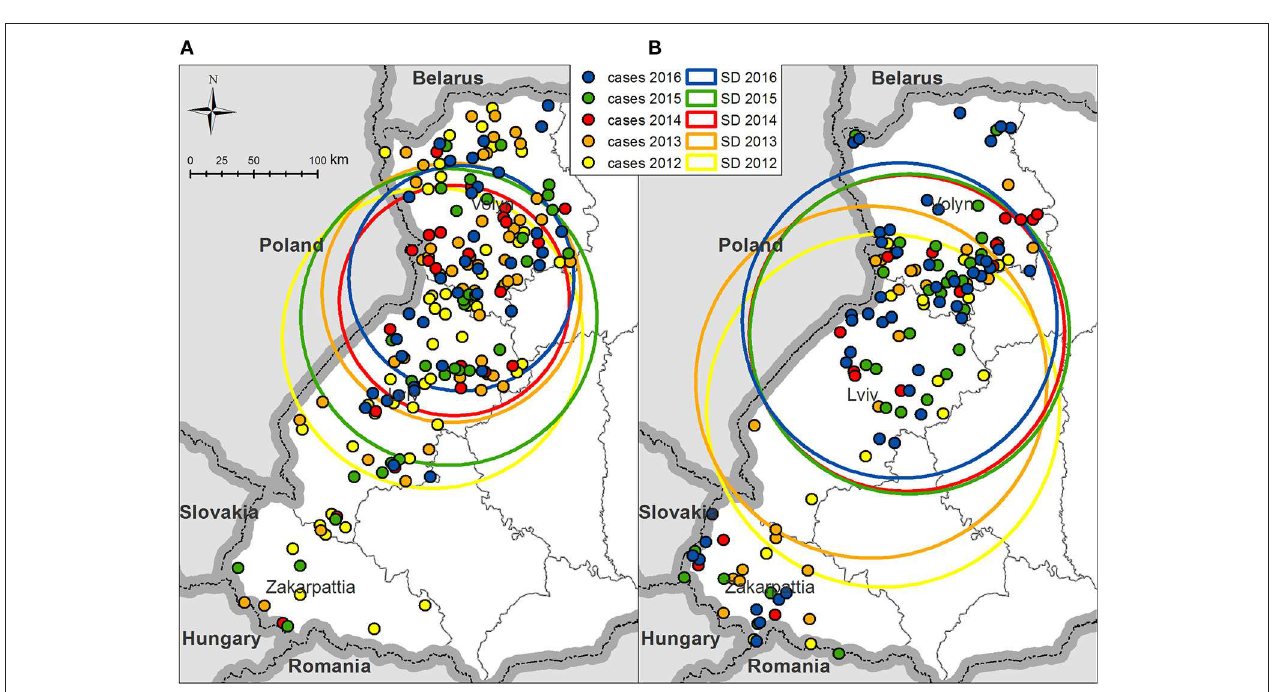
FIGURE 3 | Standard distances of rabies cases in Volyn, Lviv, and Zakarpattia oblasts on an annual basis (A) in foxes and (B) in domestic carnivores. Colored circles represent 1 standard deviation of rabies cases dispersion in foxes or domestic carnivores for the corresponding year. The center of each circle is the averaged geographical coordinates of all cases of rabies in foxes or domestic carnivores for each year. (116 km) and shifting to the north (21 km) was not observed in 2015, because rabies cases in foxes in Zakarpattia and Lviv oblasts increased. In 2016, most rabies cases in foxes concentrated in the south and in the center of Volyn and north of Lviv